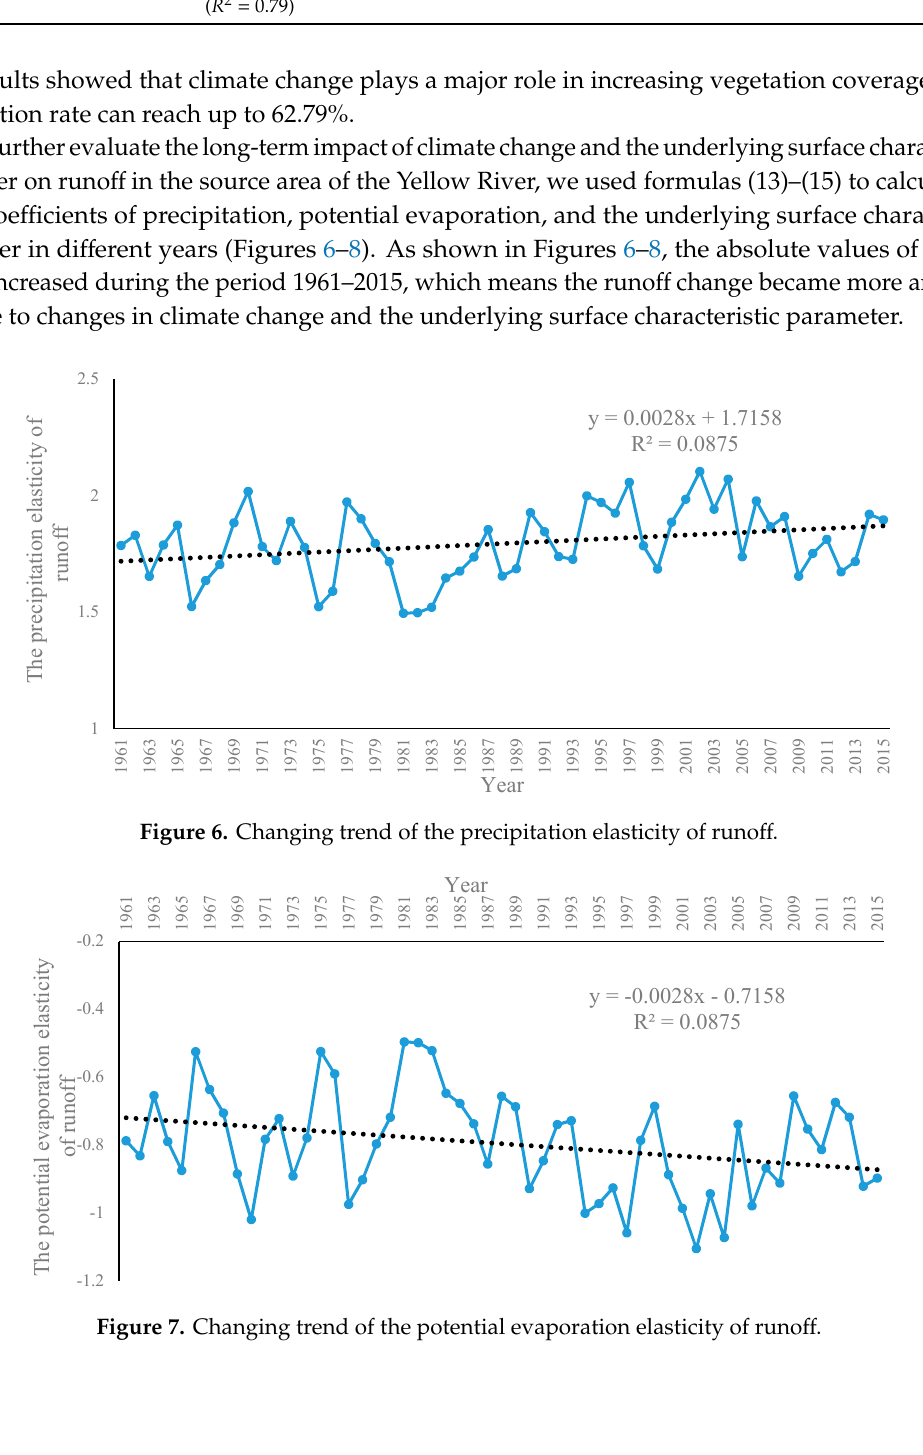
Figure 8. Changing trend of the underlying surface characteristic parameters elasticity of runoff. Table 2 showed the eigenvalues of different climatic and hydrologic variables in different periods: T 1 and T 2 . Next, we calculated the differences in annual average precipitation, potential evaporation, and the underlying surface characteristic parameters between the two different periods. Then, the runoff variation value of Tangnaihai station caused by precipitation, potential evaporation, and LUCC were calculated by formula (19)–(21). Runoff variation caused by LUCC can be separated into two parts: natural and human factors; their contribution ratios can be obtained from Table 1.